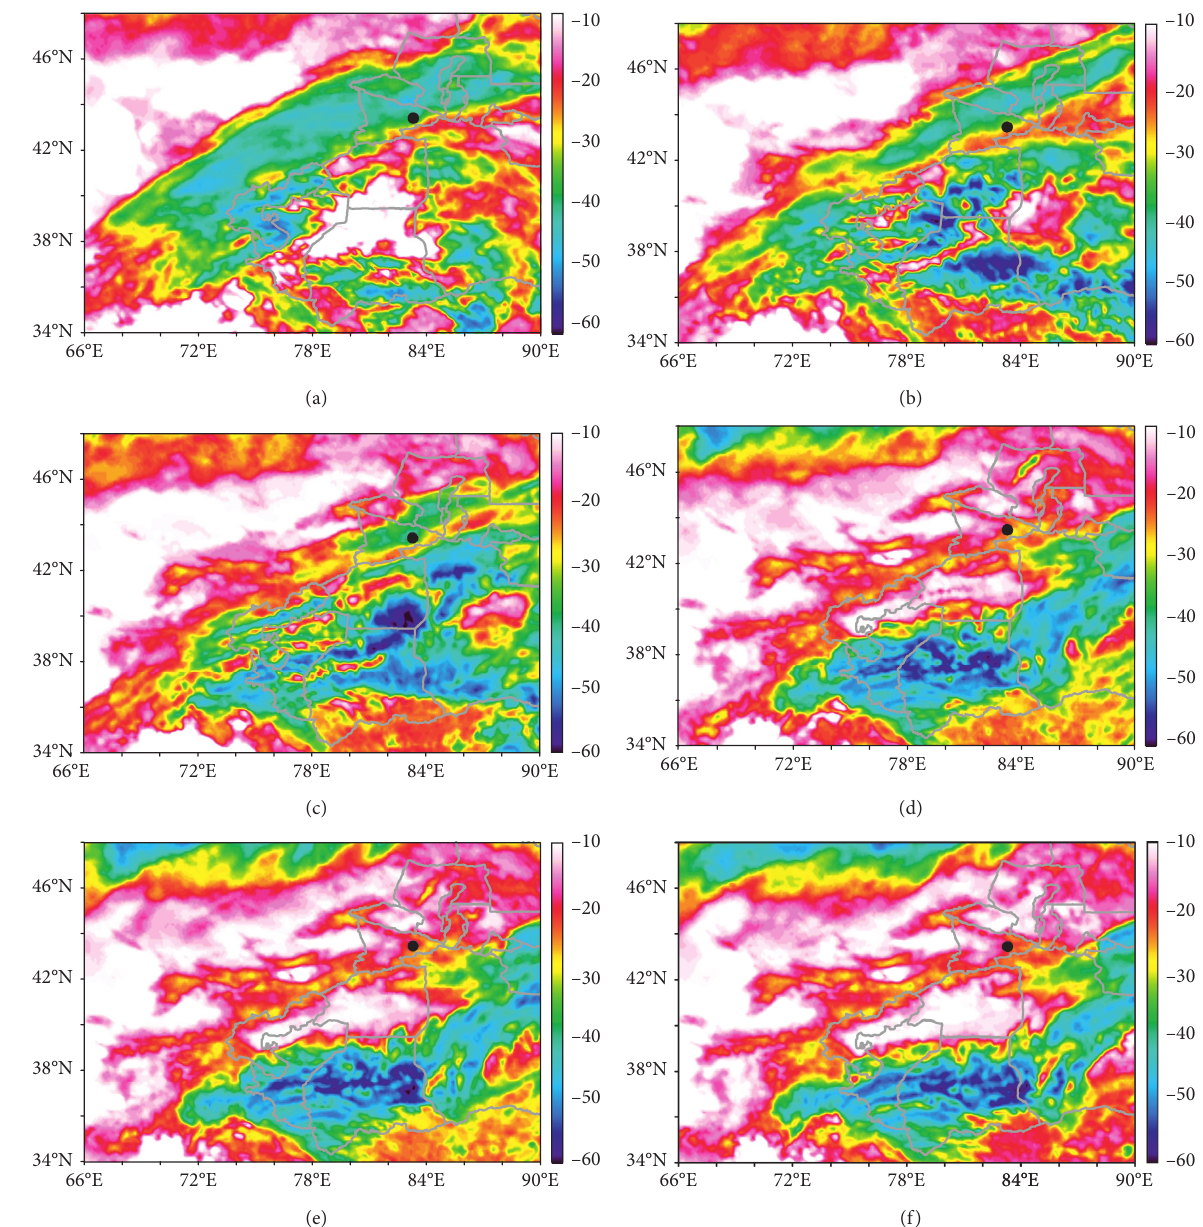
Figure 5: Evolution of TBB of FY-2G: (a) at 12: 00 on February 18, (b) at 16 :00 on February 18, (c) at 19: 00 on February 18, (d) at 00:00 on February 19, (e) at 01: 00 on February 19, and (f) at 02: 00 on February 19